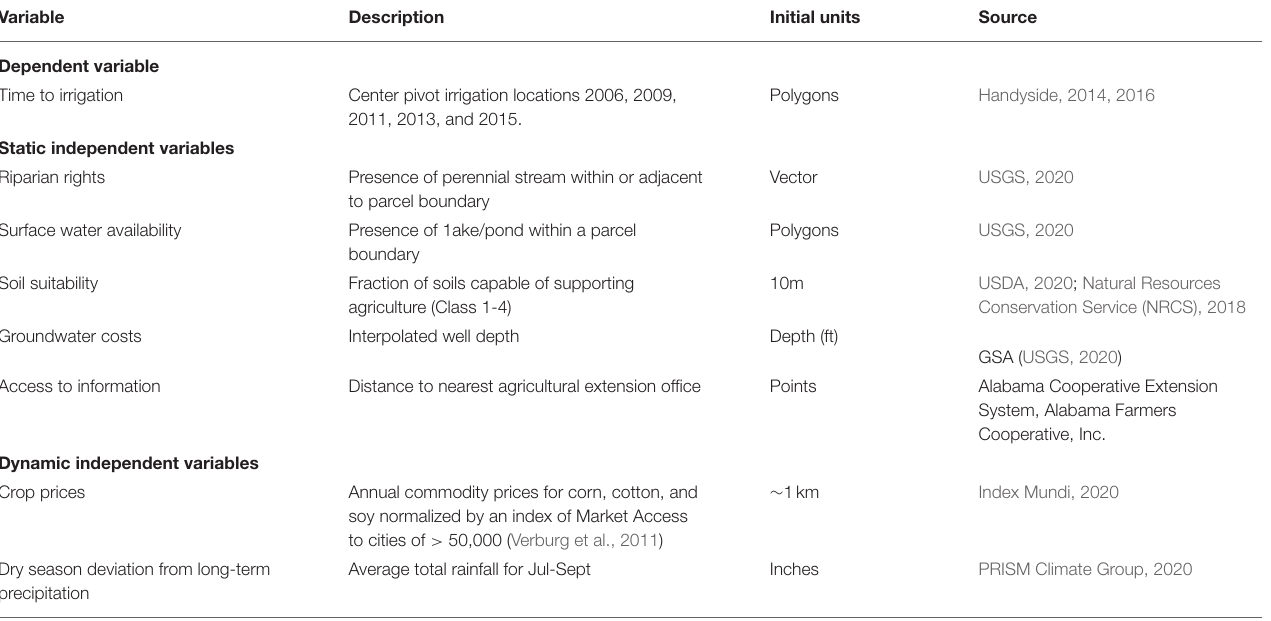
TABLE 3 | Description and metadata of dependent and independent variables used in the survival